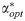
Analysis of self-replicator model of bacterial growth.A: Phase-plane analysis of the self-replicator model of Eqs 3 and 4. The nullclines for p and r are shown as solid and dashed curves, respectively. Parameter values are eM = 3.6 h-1, kR = 3.6 h-1, KR = 1 g L-1, β = 0.003 L g-1, α = 0.45. B: Dependence of the growth rate at steady state μ* on the resource allocation parameter α, for two different environmental conditions (solid line, eM = 4.76 h-1; dashed line, eM = 1.57 h-1, other parameter values are kR = 2.23 h-1, KR = 1 g L-1, and β = 0.003 L g-1). The maximal growth rate is attained for a unique α, called αopt*.